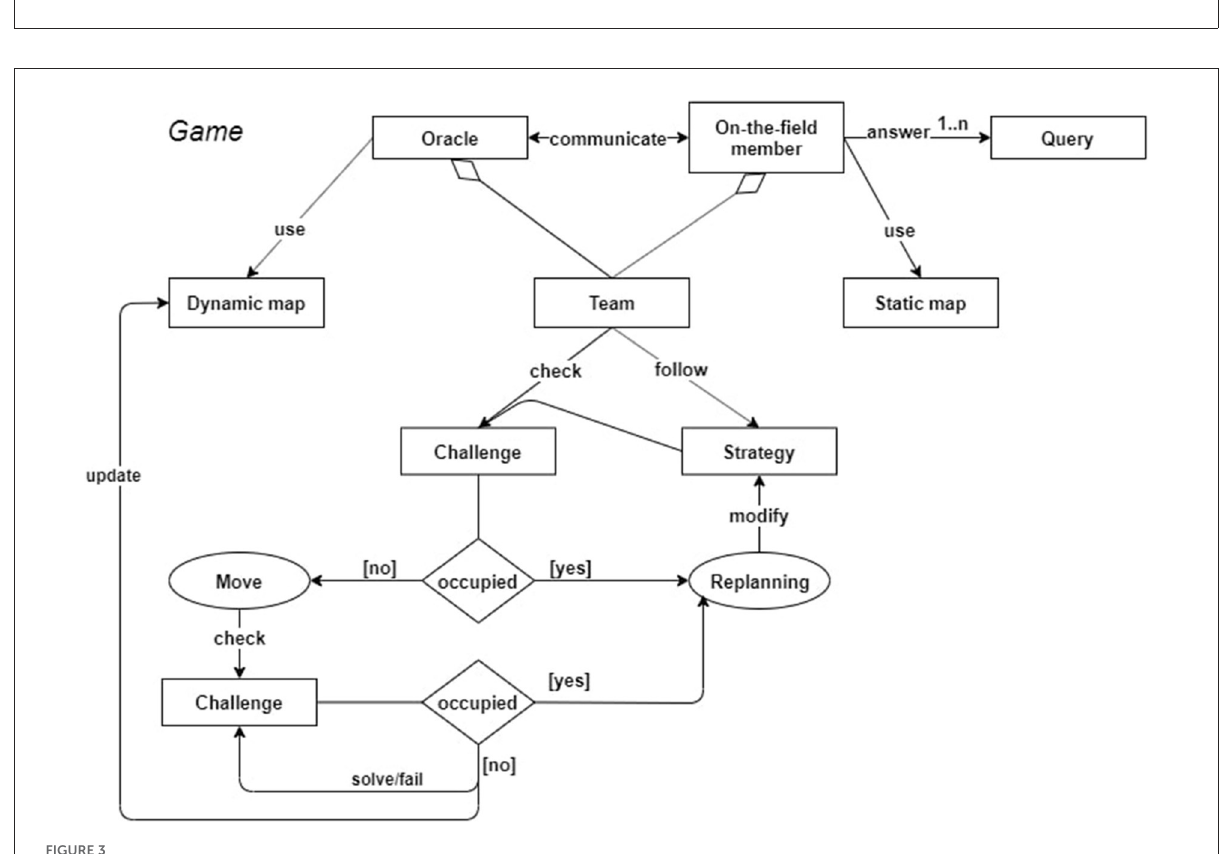
FIGURE3 Smart Rogaining